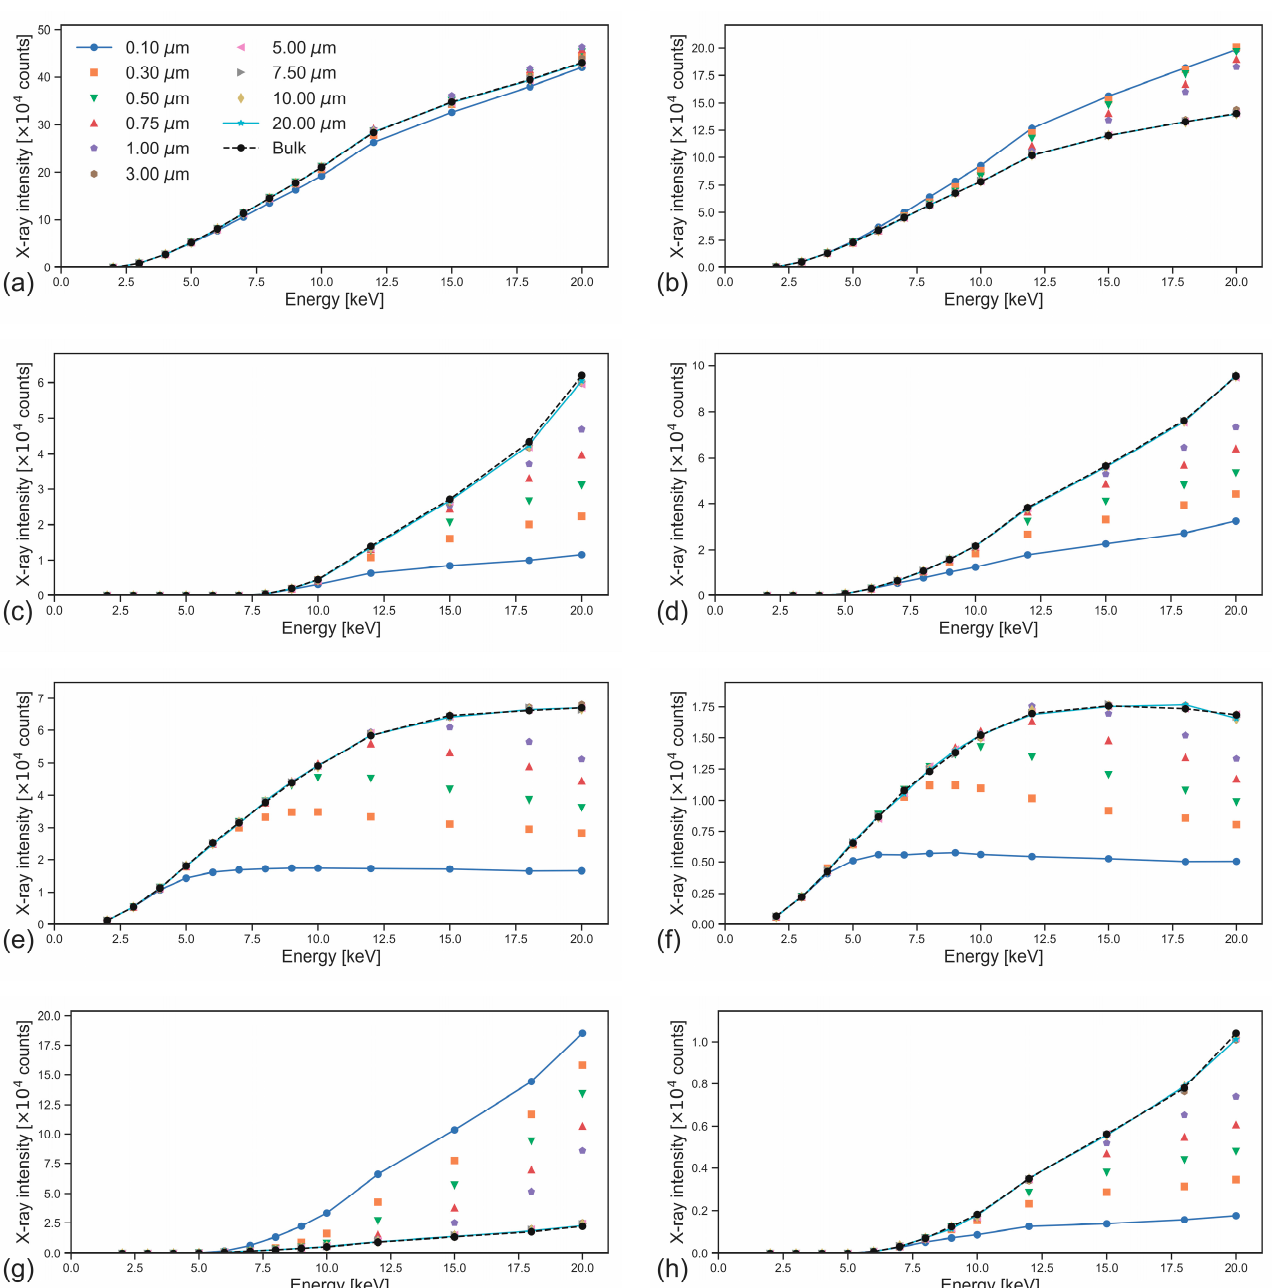
Figure 3. Integrated X-ray intensities of ( a ) Si, ( b ) Al, ( c ) Fe, ( d ) Ca, ( e ) Mg, ( f ) Na, ( g ) K and ( h ) Ti K α lines, plotted as a function of the electron beam energy and for different radii of the basalt-derived glass fibre. The graphs report also the trend simulated for the bulk-like material (black dashed line). Legend in ( a ).